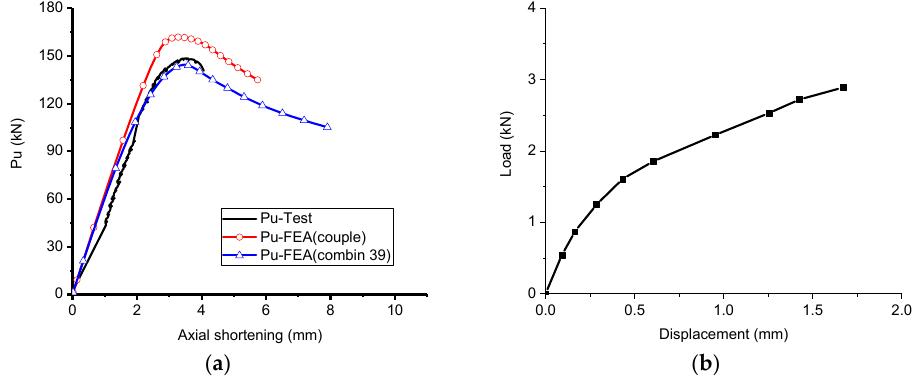
Figure 11. Numerical simulation results and details ( a ) Load-axial shortening curves of S1; ( b ) Curve of spring force and displacement.